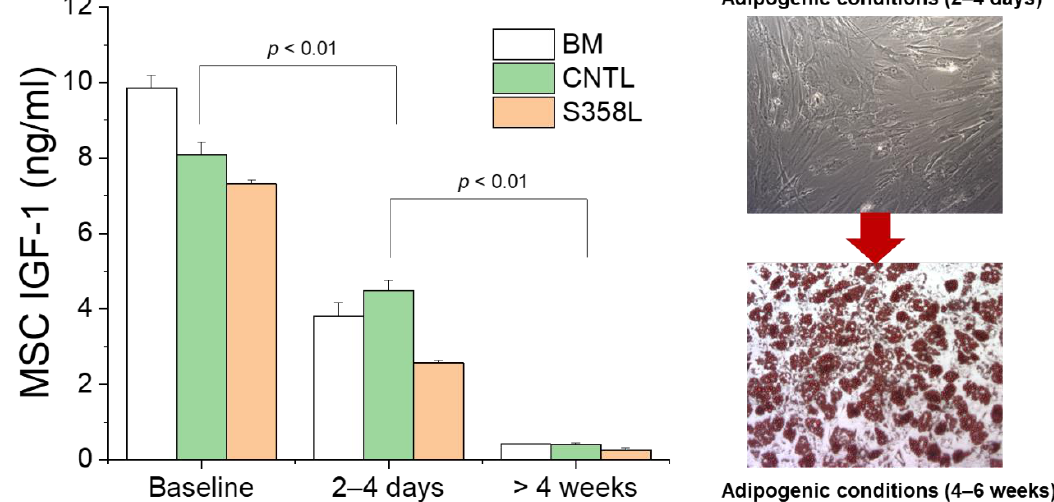
Figure 7. Shown are IGF-1 section levels during adipogenic conditioning of bone marrow (BM) MSCs and MSCs derived from control (CNTL MSC) and S358L (S358L MSC) iPSCs. After 2 – 4 days of adipogenic conditioning ( n = 3, n = 6, n = 6), IGF-1 levels are significantly reduced compared to before adipogenic conditioning was initiated (baseline, n = 3, n = 3, n = 3). After >4 weeks of adipogenic conditioning, when MSCs have differentiated to adipocytes (bottom right, n = 5, n = 4, n = 6), IGF-1 levels are negligible compared to baseline.